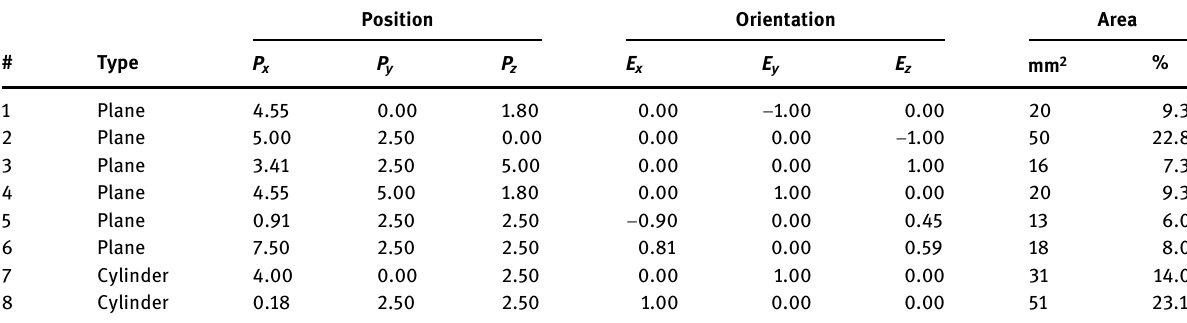
Table 3: Numeric description of part features for sample part 1 Position Orientation